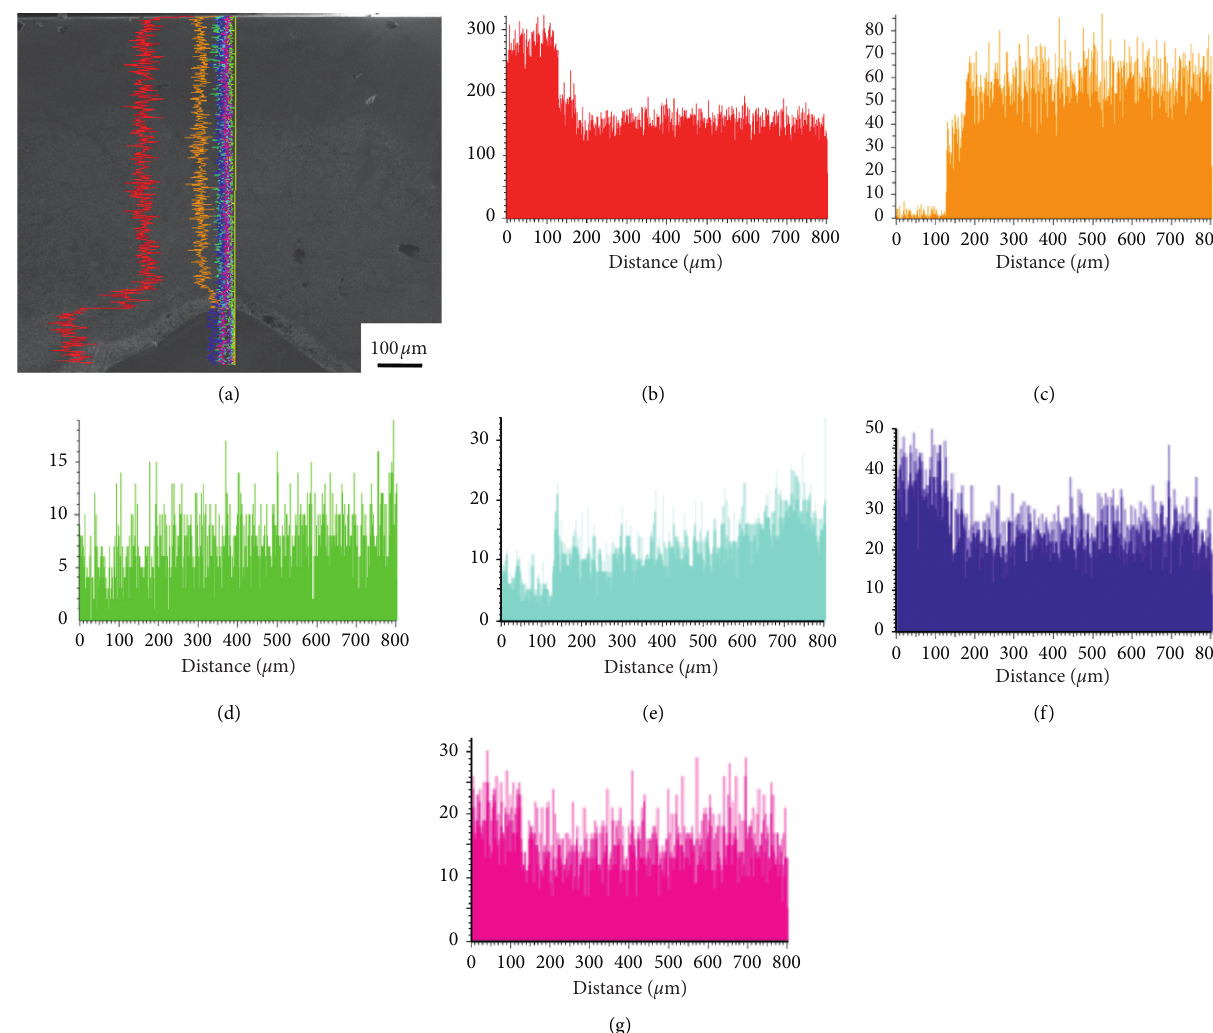
Figure 5: The results of line scanning analysis from the substrate to the coating of sample S2: (a) line scan image; (b) Ti element, (c) Ni element, (d) B element, (e) C element, (f) V element, and (g) Ce